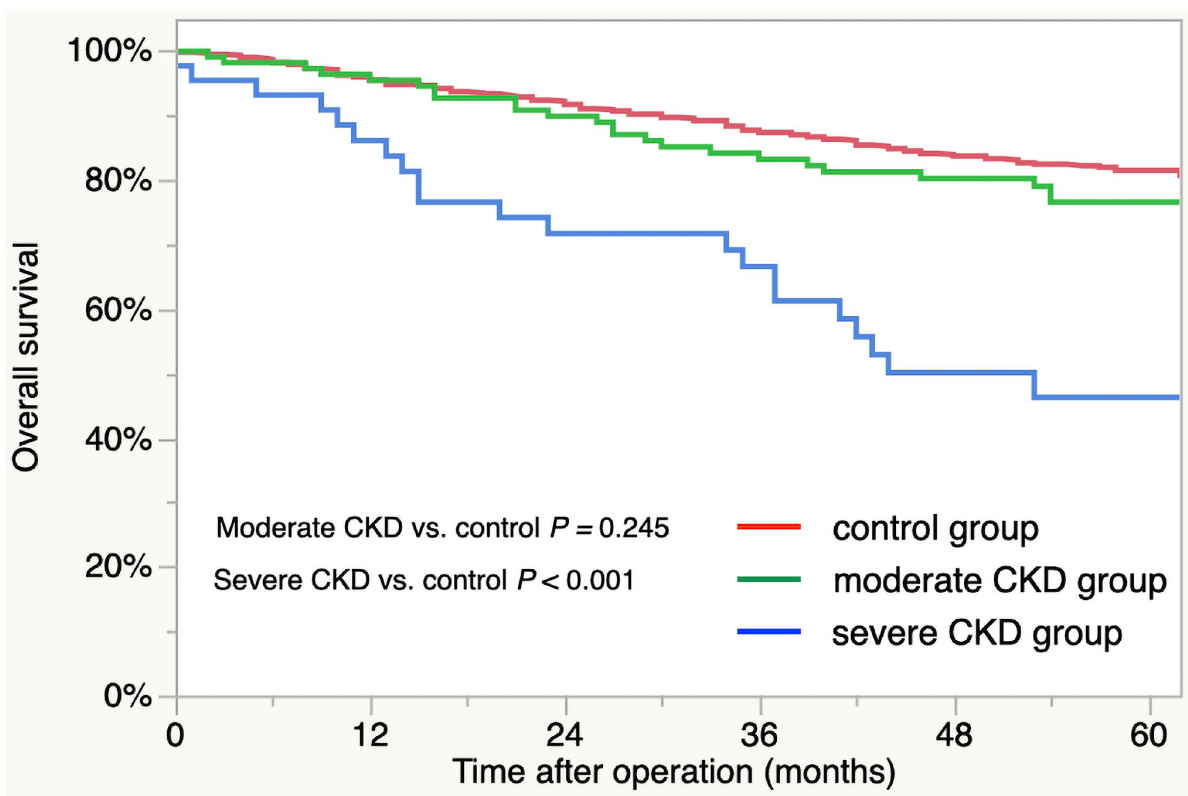
Fig 1. Overall survival of CKD groups: Control group (red line), moderate CKD group (green line), and severe CKD group (blue line).